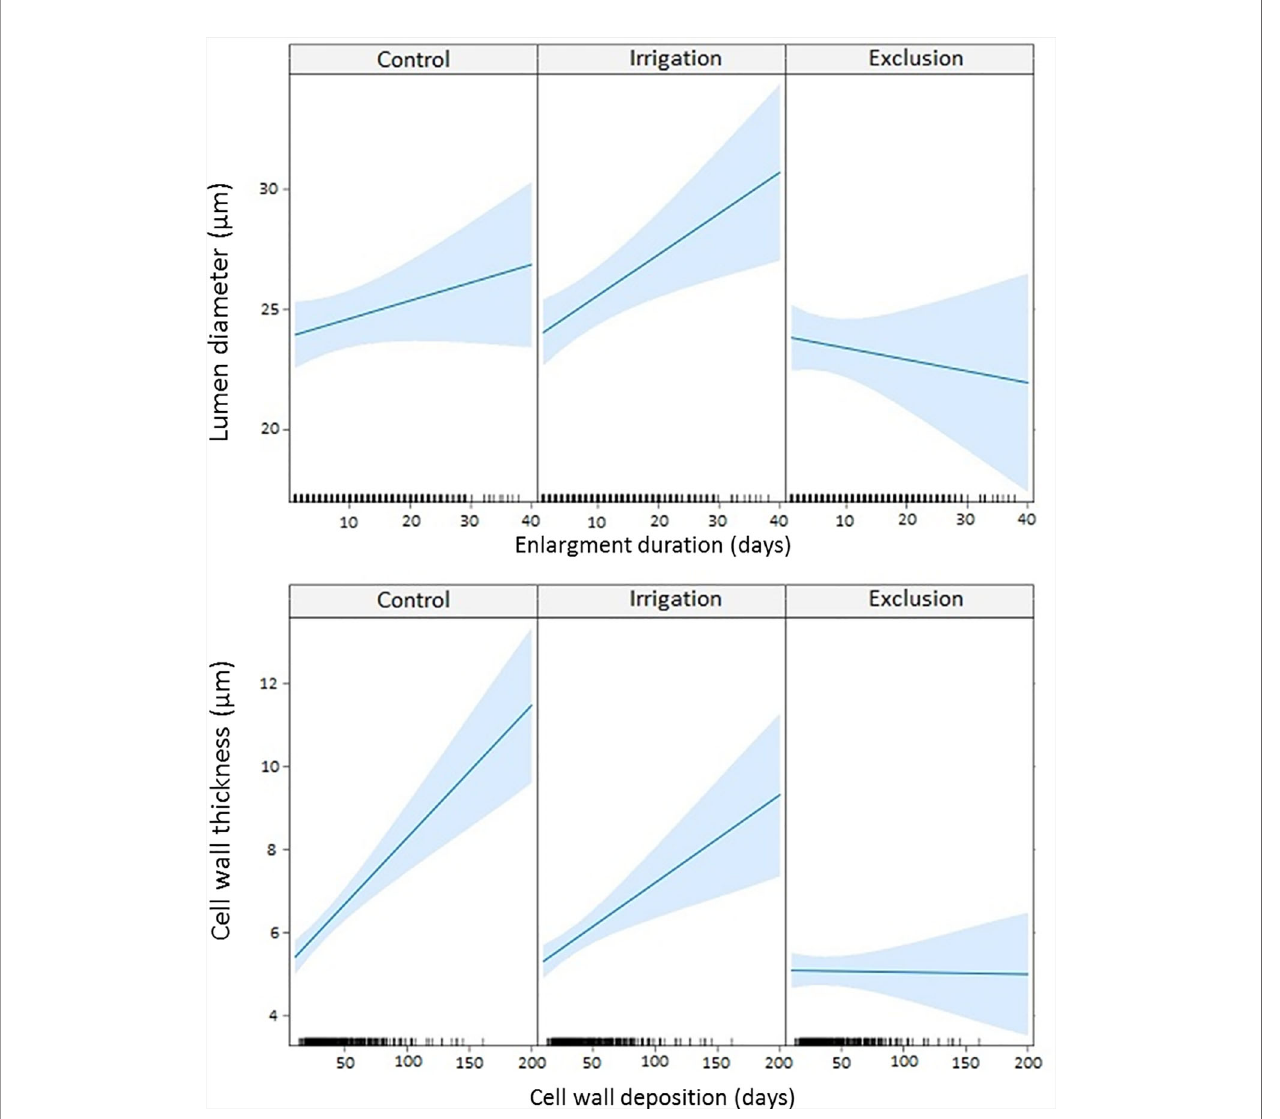
FIGURE 6 | Linear mixed model (LMM) between lumen diameter and enlargement duration; and between cell wall thickness and cell wall deposition duration. Ticks in the x-axis represent the observed